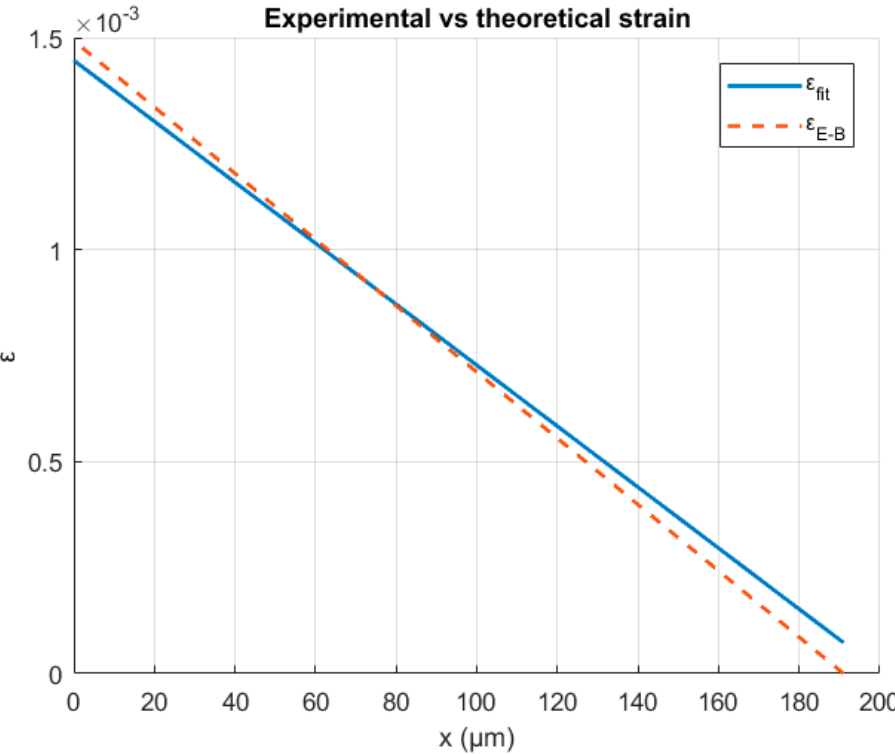
Figure 4. The AFM cantilever bending strain as calculated from the Raman shift (linear regression) and compared with the Euler–Bernoulli approximation.